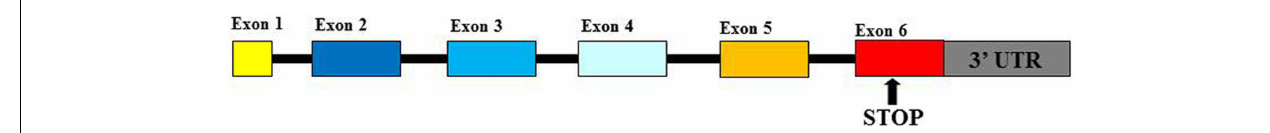
FIGURE 1 | Human leukocyte antigen-G gene . UTR, un-translated region.